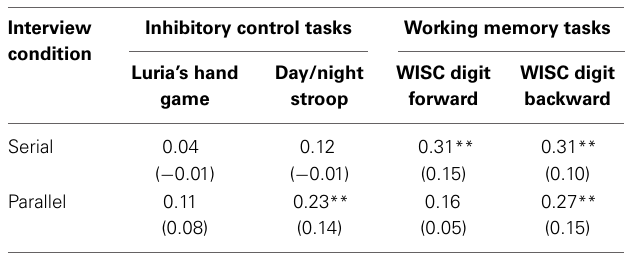
Table 6 | Correlations between executive function scores and source accuracy in the serial and parallel interview